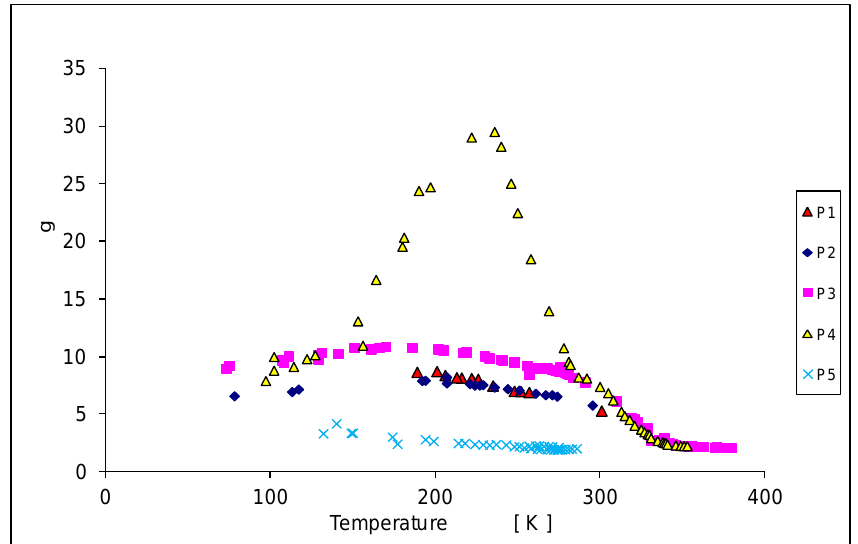
Figure 7. The temperature dependence of the effective gyromagnetic factor g e .